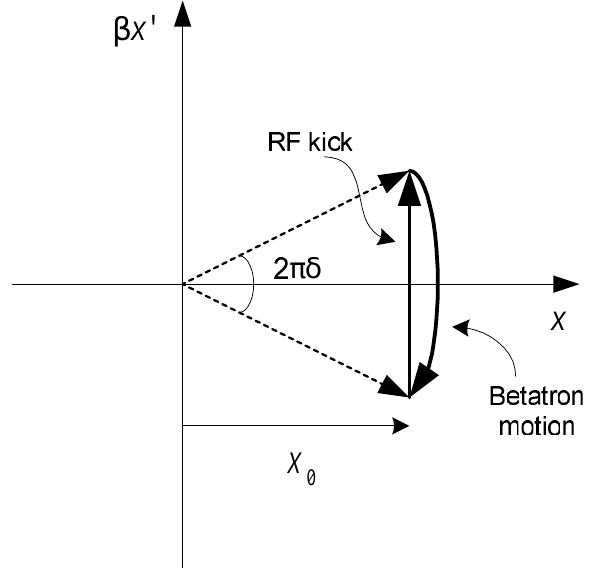
FIG. 2. Beam oscillations excited by the rf dipole are shown in the phase space rotating with the rf frequency. The amplitude of the excited beam oscillations, X 0 , is determined by the rf kick amplitude and the rf frequency separation from the betatron 1 k . This stable mode of the excited beam tune d (cid:1) n x 2 f rf f circ oscillations is achieved when rf dipole is turned on